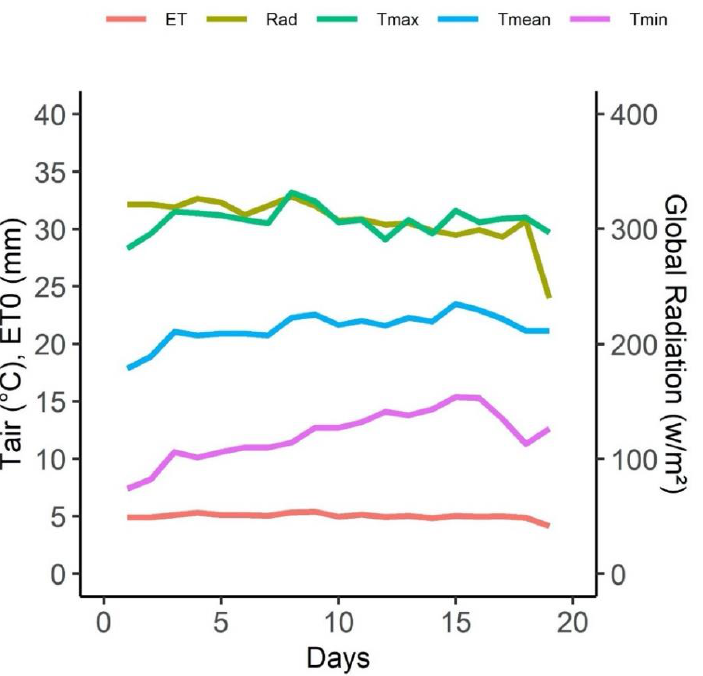
Figure 1. Climate variables during experiment. Daily values of minimum (Tmin, pink line), maximum (Tmax, dark green line) and mean (Tmean, blue line) temperature, daily reference evapotranspiration (ET, red line) and daily mean global radiation (Rad, light green line) through assay.